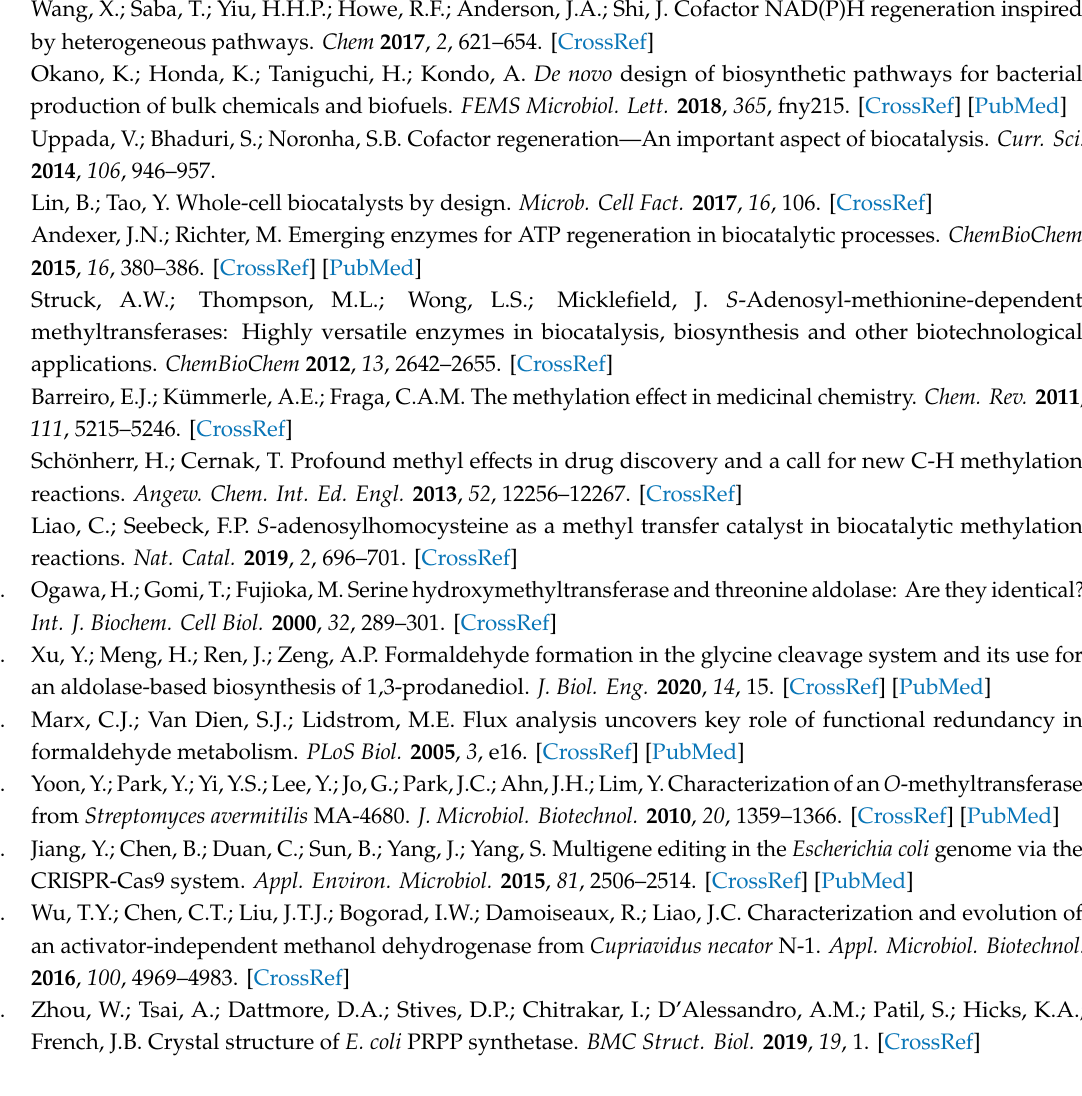
Figure S1: Schematic illustration of the regulation of methionine / SAM biosynthesis, Figure S2: Deletion of the metJ gene in E. coli BL21 (DE3), Figure S3: Methylation reactions with Bacillus methanolicus MDH-driven methanol metabolic pathway for 5-methyl-THF formation, Table S1: Concentration of the methylated compounds produced by OMT / BL21 cells, Table S2: Sequence of oligonucleotide primers used in this study, Table S3: Sequences of codon-optimized omt and mdh synthetic